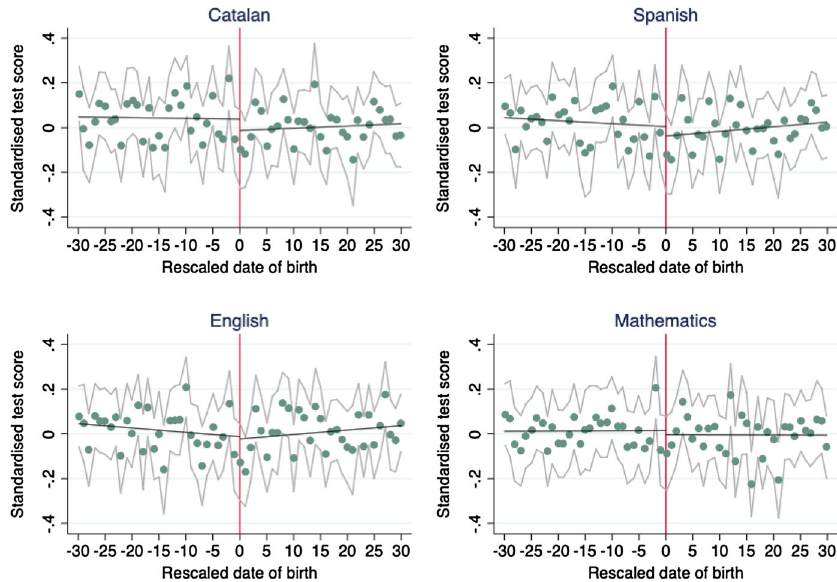
Fig. 5 RD plots by subject, 2019